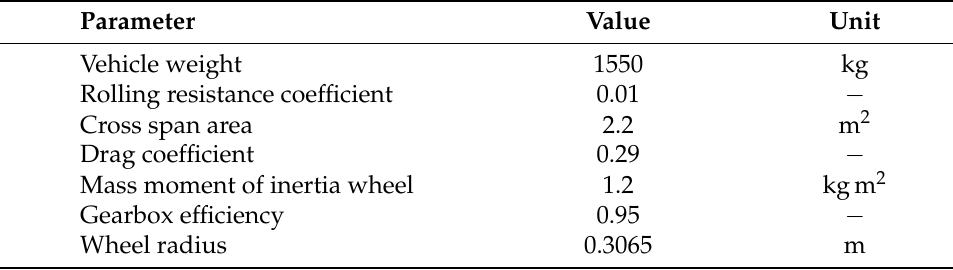
Table 2. Parameters of the example